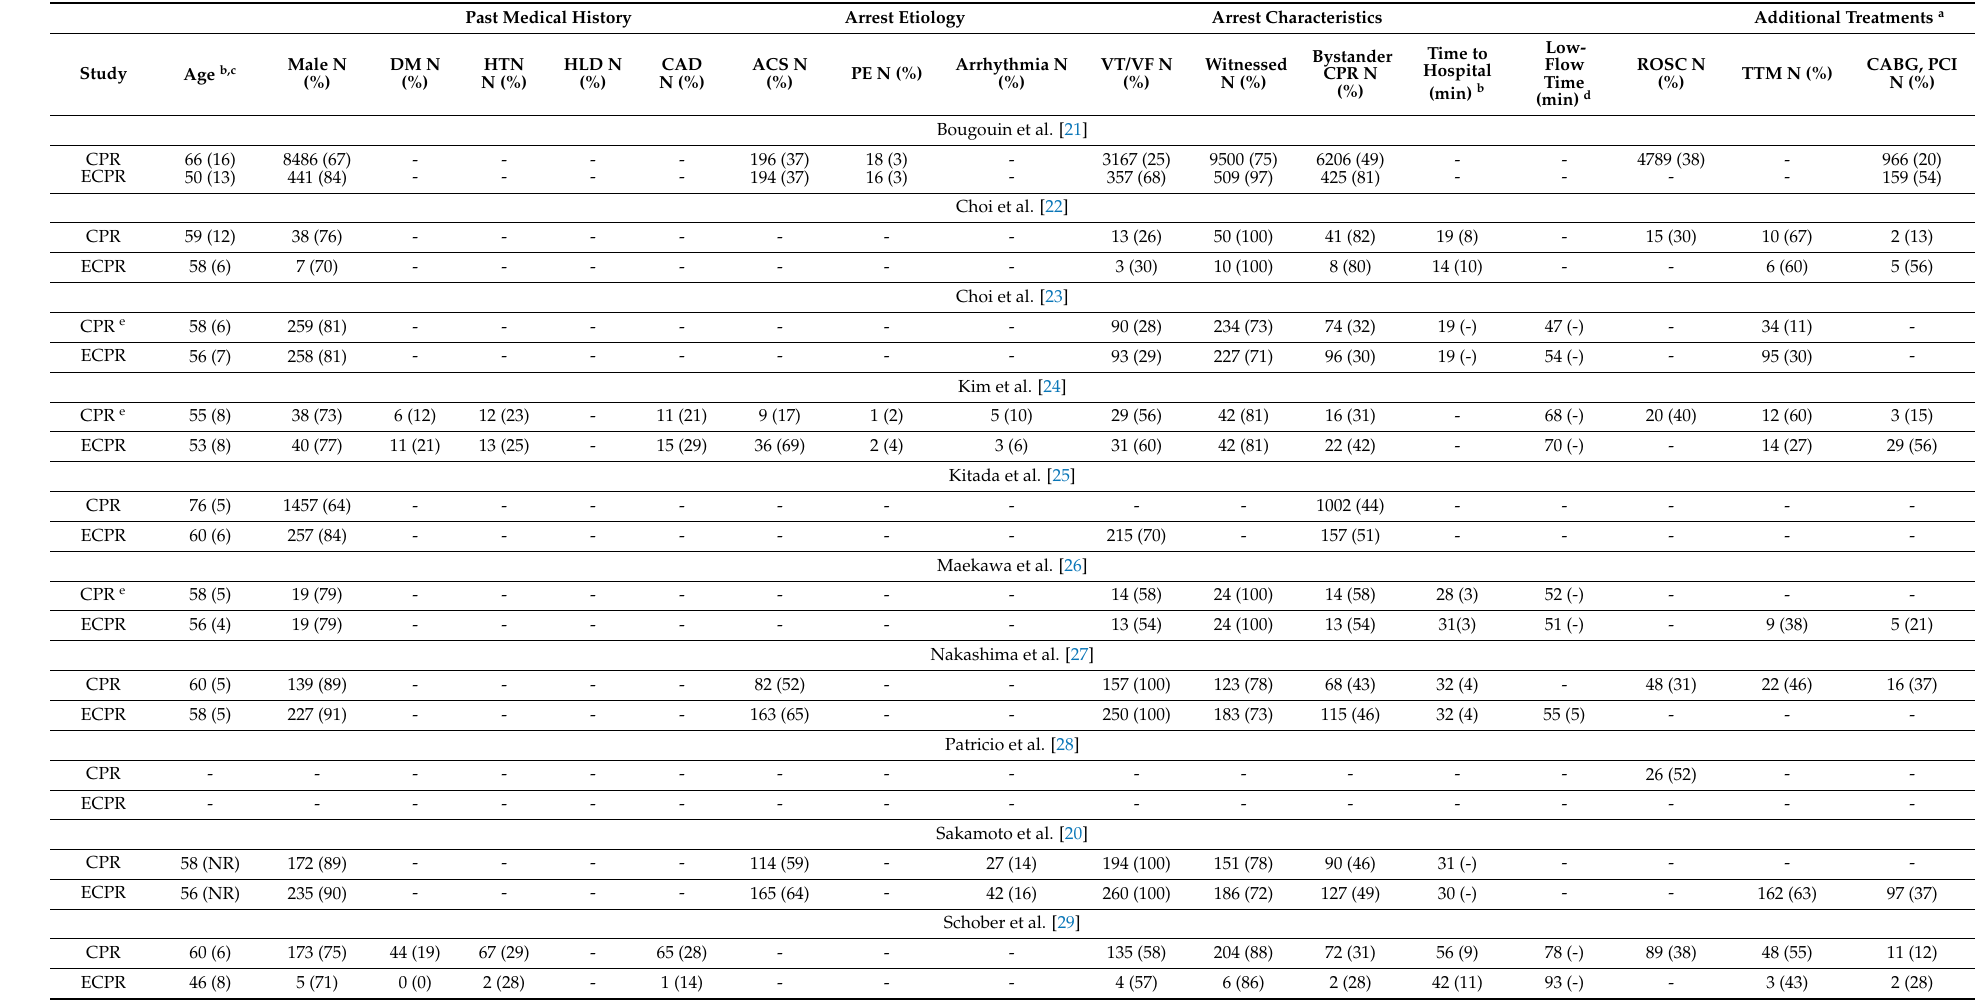
Table 2. Demographics and characteristics of arrest in patients treated with conventional CPR and